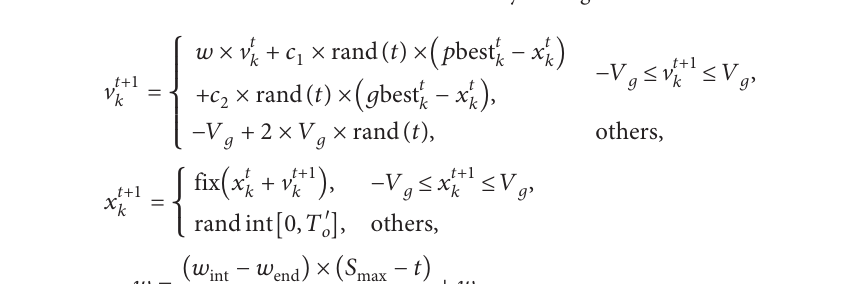
Figure 3: The flowchart of the hybrid